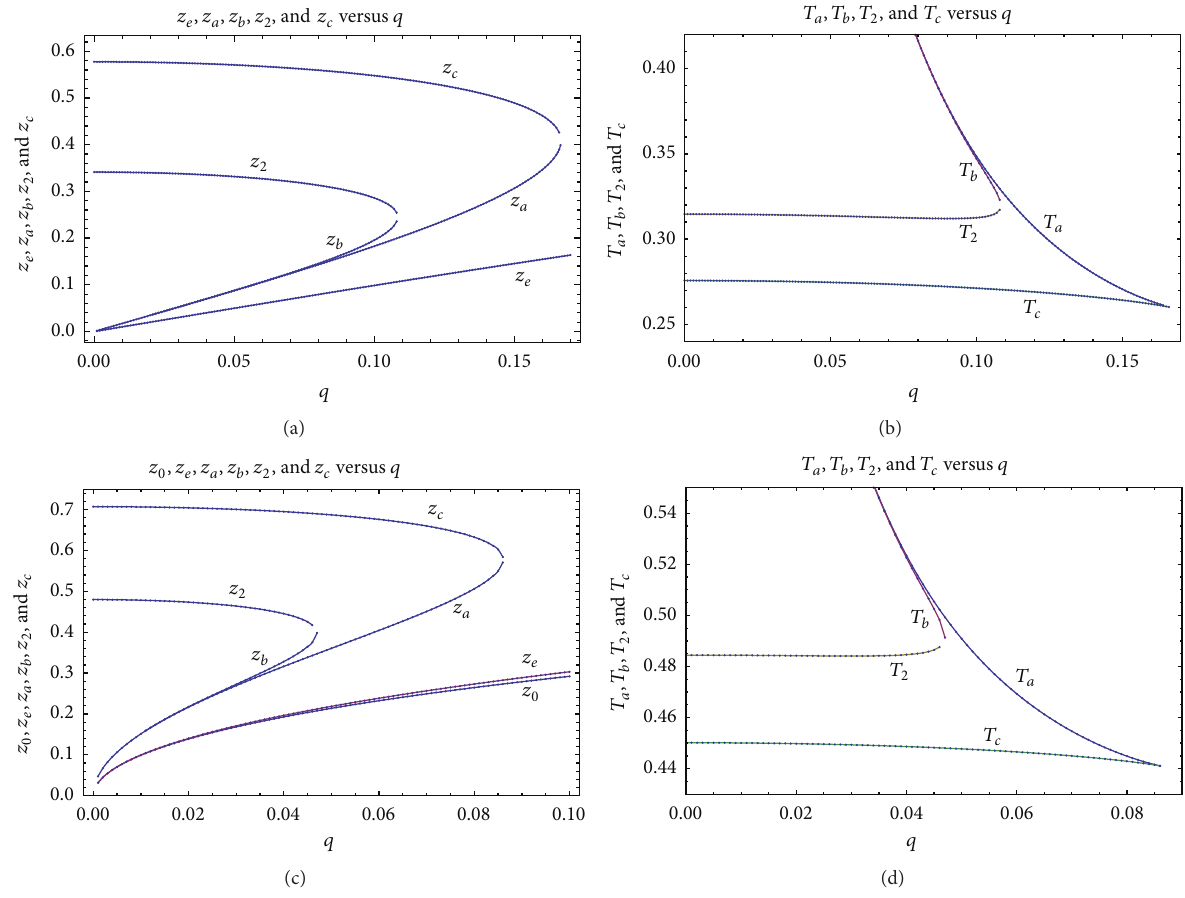
Figure 7: The heat capacity condition 𝑆 󸀠󸀠 (𝐸 𝑟 ) < 0 is characterized by the sizes 𝑧 𝑒 , 𝑧 𝑎 , 𝑧 𝑏 , 𝑧 2 , and 𝑧 𝑐 . Allowed region is the area between the line 𝑧 𝑎 - 𝑧 𝑐 and line 𝑧 𝑏 - 𝑧 2 . In (a) and (b): the sizes 𝑧 𝑒 , 𝑧 𝑎 , 𝑧 𝑏 , 𝑧 2 , 𝑧 𝑐 and the corresponding temperatures versus the bulk charge 𝑞 for AdS 4 . In (c) and (d): the sizes 𝑧 𝑒 , 𝑧 𝑎 , 𝑧 𝑏 , 𝑧 2 , and 𝑧 𝑐 and the corresponding temperatures versus the bulk charge 𝑞 for AdS 5 . For all plots, we set 𝑔 𝑏 = 𝑔 𝑓 = 2 .